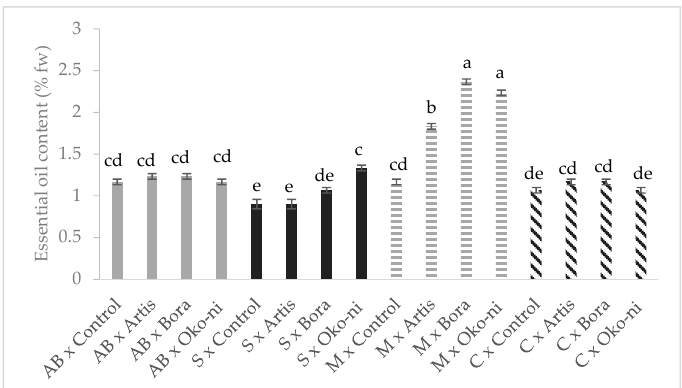
Figure 2. Interaction effects of cultivar and myco-biocontrol formulate on essential oil content of basil. Values with the same lower-case letters are not statistically different at p < 0.05 according to Tukey’s test. AB—‘Aromat de Buzau’; S—‘Serafim’; M—‘Macedon’;